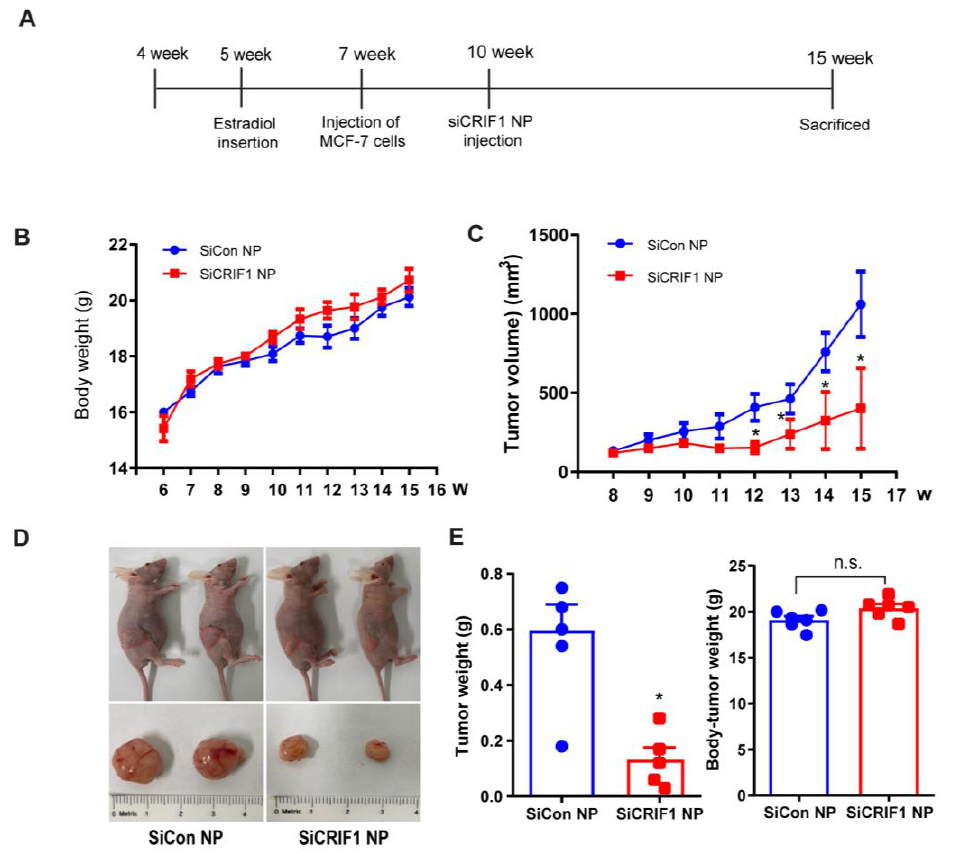
Figure 5. CRIF1 siRNA-encapsulated PLGA nanoparticles inhibited tumor growth in MCF-7 xenograft mice. ( A ) Schematic representation of MCF-7 xenograft mouse model and administration of NP. ( B ) Body weight. ( C ) Tumor volume. ( D ) Representative photographs of tumor-bearing mice and extracted tumor. ( E ) Tumor weight and body-tumor weight in siCon NP and siCRIF1 NP groups. All data are presented as means ± SEM of at least three independent experiments ( n = 5 mice in each group; * p < 0.05 vs. siCon NP group).